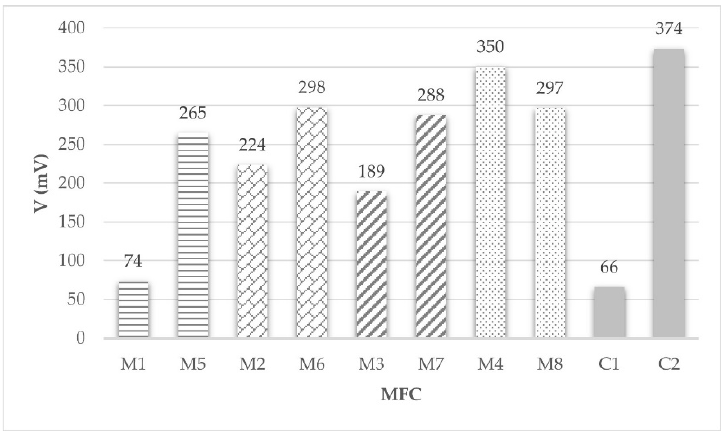
Figure 4. Maximum voltage recorded in each MFC during open-circuit operation; each bar corre- sponds to an experiment using the experimental design.